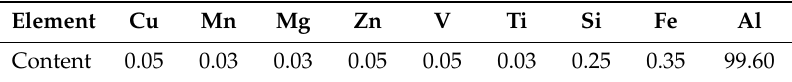
Table 2. Chemical constituents of aluminum (wt%).